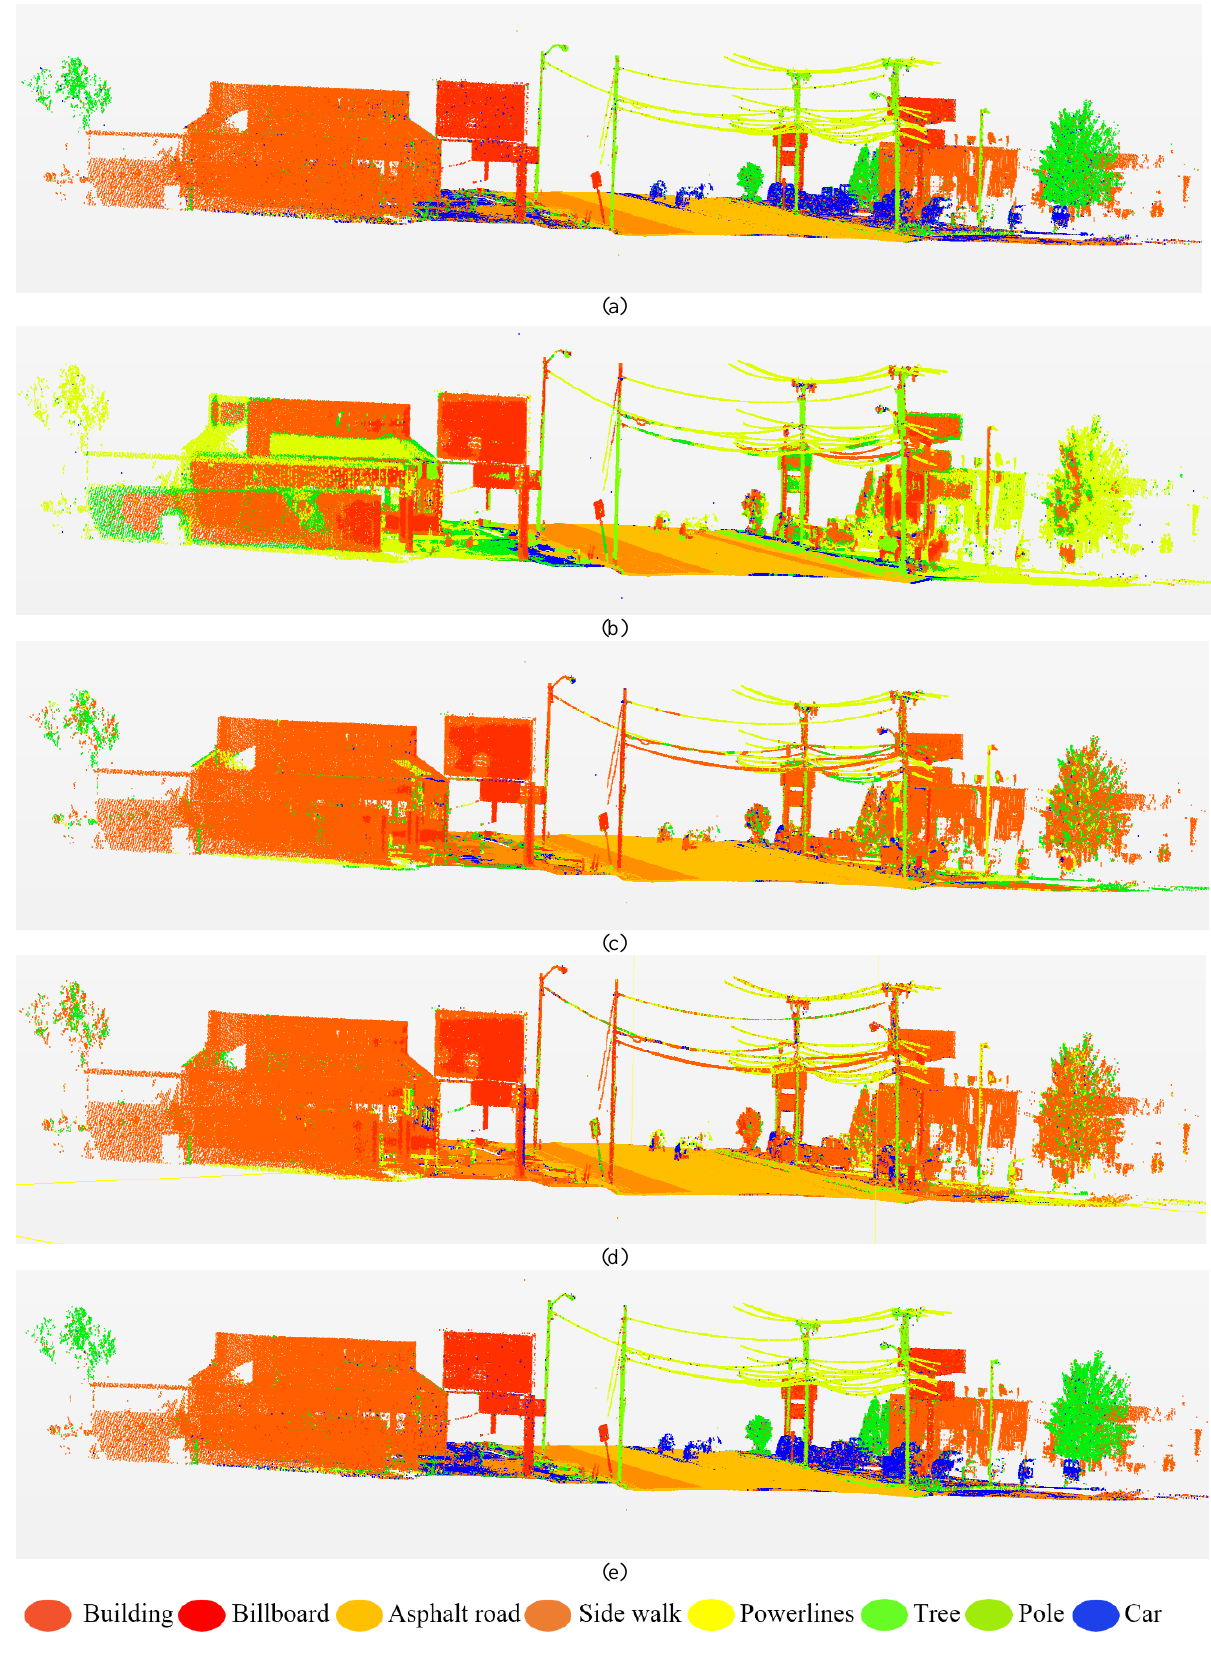
Figure 1. Classification Results of methods: (a) k-NN ; (b) GNB; (c) SVM; (d) MLP; (e)